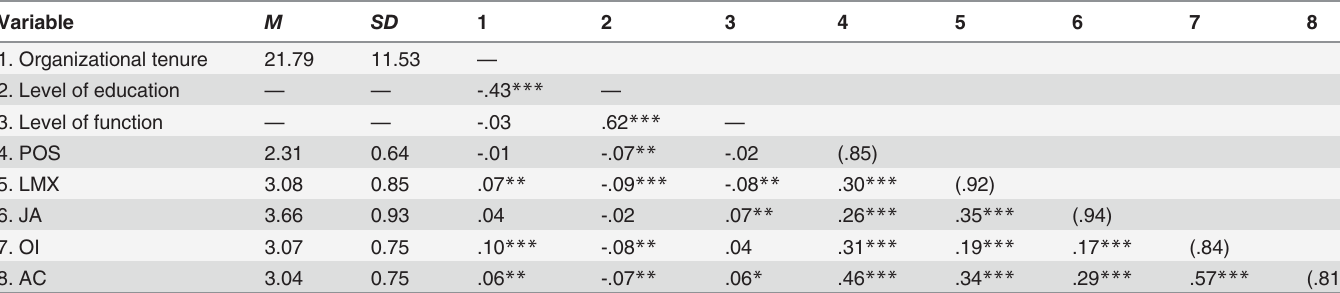
Table 2. Study 2: Descriptive Statistics and Intercorrelations Among Variables.